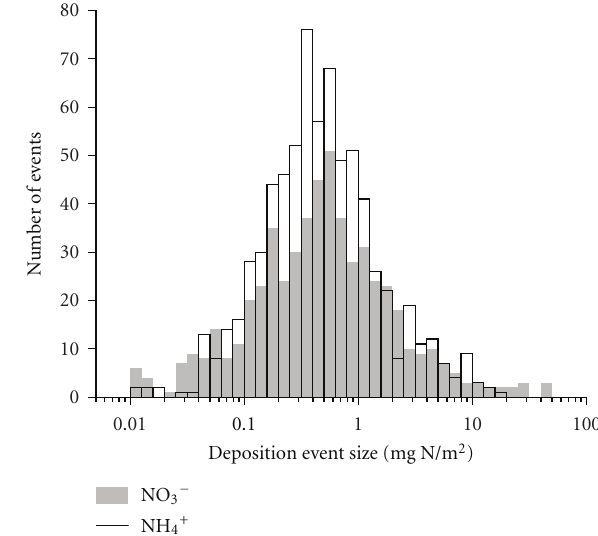
Figure 3: Histogram of nitrogen deposition samples. Grey bars show nitrate histogram; black lines show ammonium